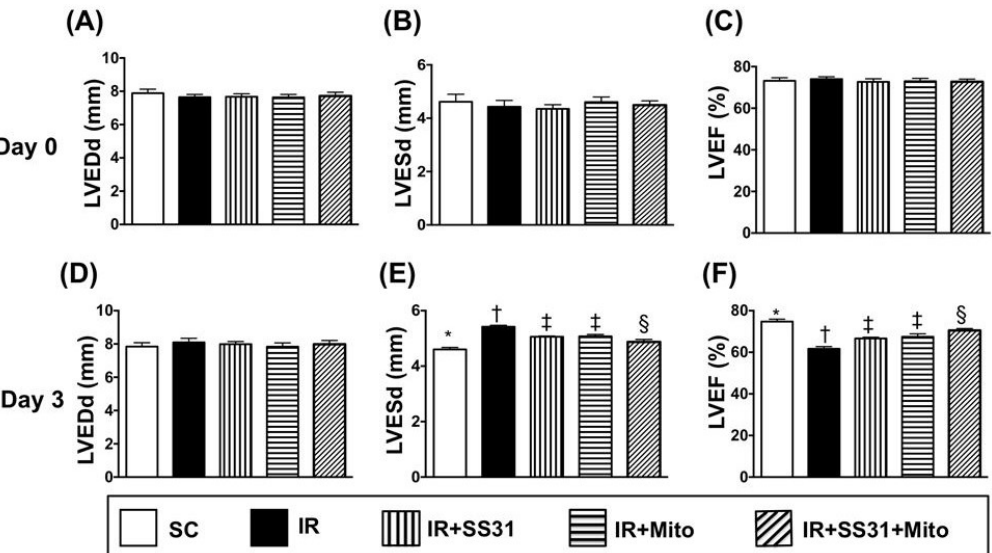
Figure 5. Transthoracic echocardiographic findings after the IR procedure. ( A ) At baseline, the left ventricular end-diastolic dimension (LVEDd), p > 0.5. ( B ) At baseline, left ventricular end-systolic dimension (LVESd), p > 0.5. ( C ) At baseline, left ventricular ejection fraction (LVEF), p > 0.5. ( D ) Upon 72 h after myocardial IR procedure, LVEDd, p > 0.3. ( E ) Upon 72 h after myocardial IR procedure, LVESd * vs. other groups with different symbols (†, ‡, §), p < 0.001. ( F ) Upon 72 h after myocardial IR procedure, LVEF, * vs. other groups with different symbols (†, ‡, §), p < 0.001. All statistical analyses were performed by one-way ANOVA, which was followed by a Bonferroni multiple comparison post hoc test ( n = 8 for each group). Symbols (*, †, ‡, §) indicate significance at the 0.05 level. SC = sham control. IR = ischemia-reperfusion. Mito = mitochondria.